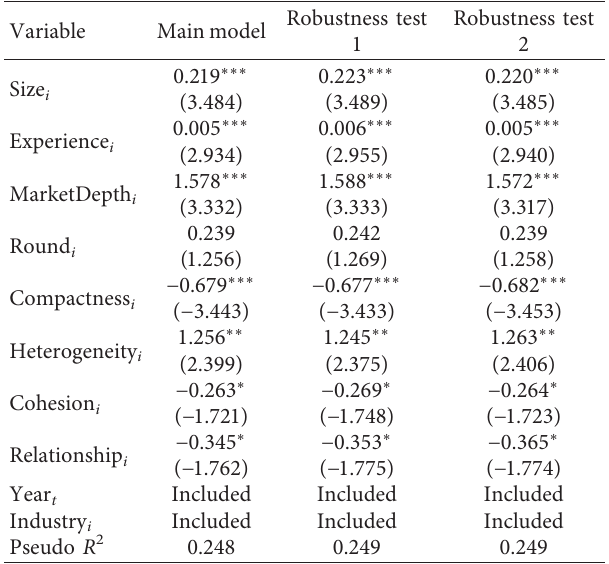
Table 3: The results of regression analysis and robustness